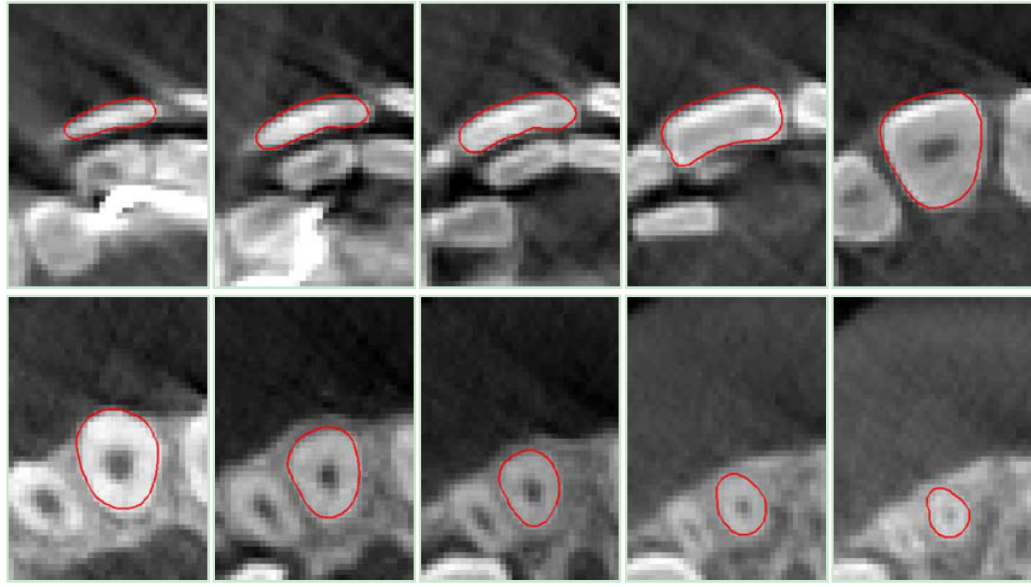
Figure 11. Results of the DRLSE method for tooth 11 , obtained by processing some CBCT slice